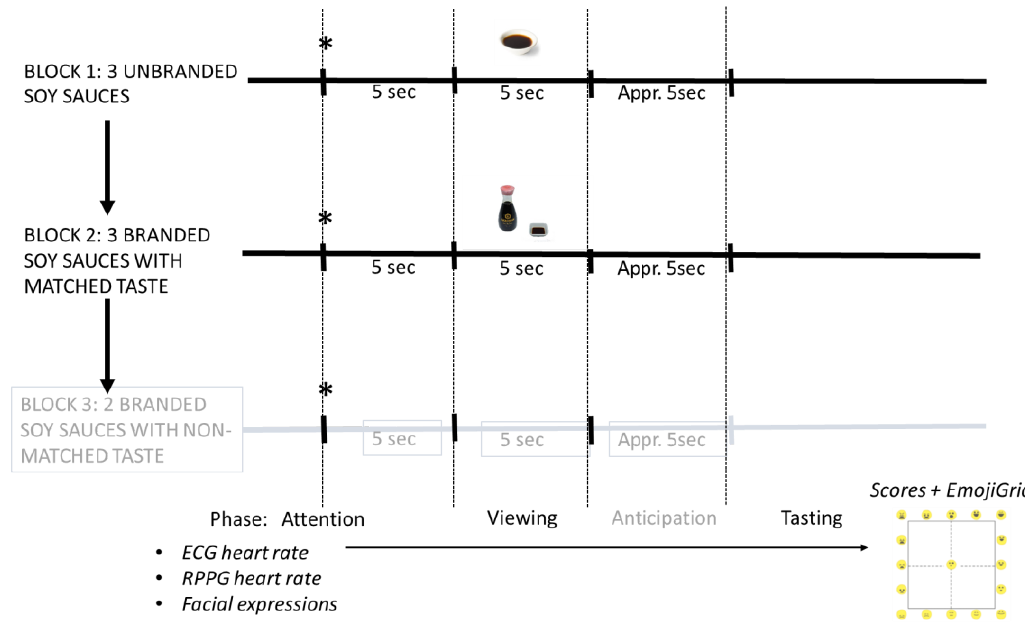
Figure 1. The EmojiGrid used in the study to measure valence and arousal [25]. 2.4. Physiological ANS Measures PPG heart rate was collected using a BIOPAC MP150 system and AcqKnowledge 5.0.4 data acquisition software (BIOPAC Systems Inc., Santa Barbara, CA, USA). Heart rate was measured using the TSD200 PPG transducer attached to the index finger of the non-dominant hand. The TSD200 transducer was also connected to the PPG/EDA